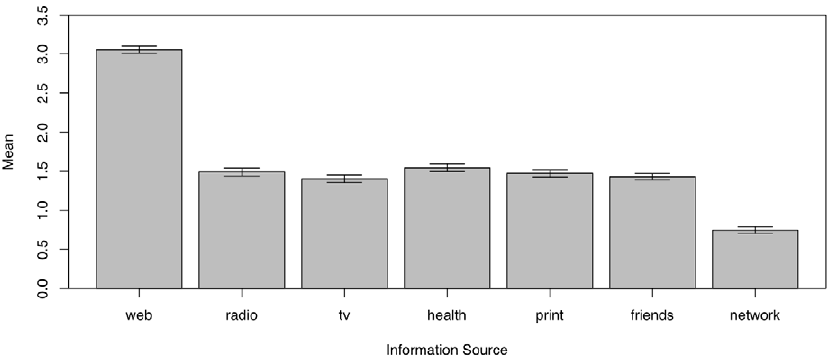
Figure 6. Mean values of sources of information on swine flu cited by respondents. Bars show Bonferroni-corrected 95% confidence intervals. Codes: 1=never use as source of information, 5=very frequently use as a source of information.